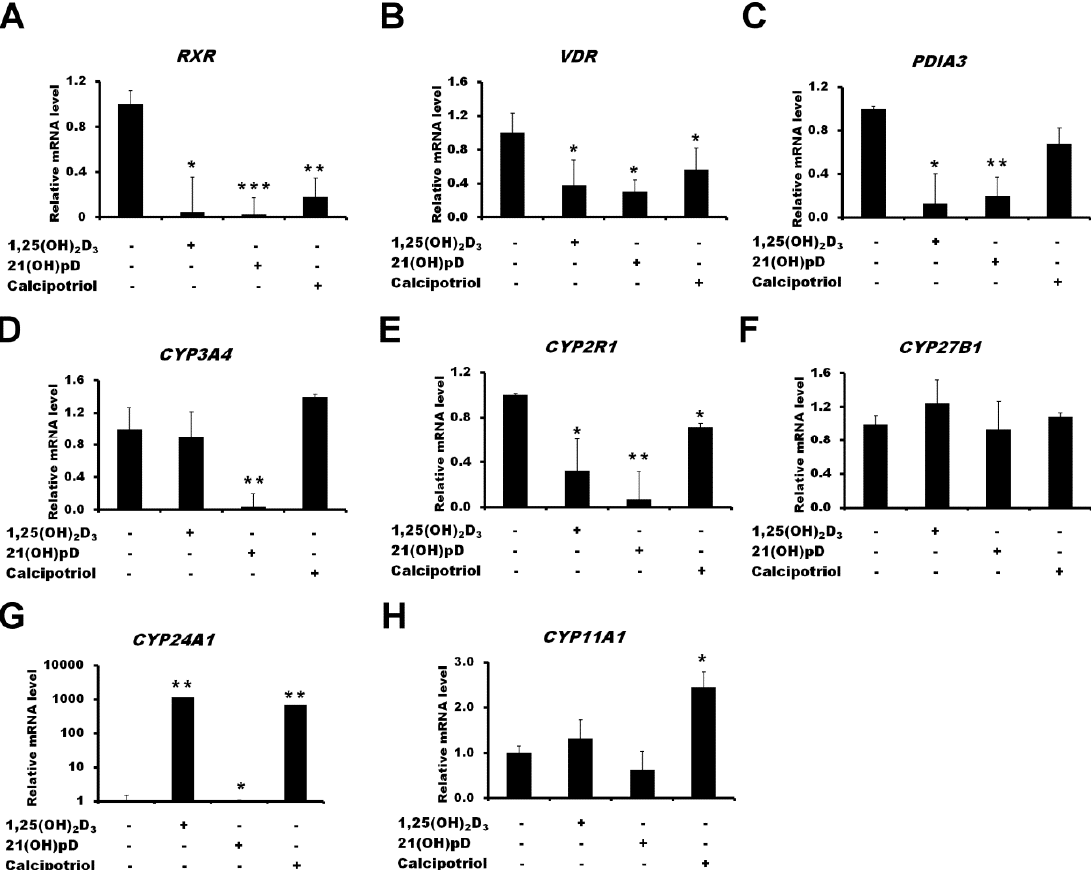
Figure 5. Effects of vitamin D compounds (1,25(OH) 2 D 3 , 21(OH)pD or calcipotriol) on RXR ( A ), VDR ( B ), PDIA3 ( C ), CYP3A4 ( D ), CYP2R1 ( E ), CYP27B1 ( F ), CYP24A1 ( G ) and CYP11A1 ( H ) genes expression in A375 melanoma cells. A375 melanoma cells were incubated with 100 nM of 1,25(OH) 2 D 3 , 21(OH)pD or calcipotriol for 24 h. mRNA levels were measured by qPCR. Data are shown as means ± S.D of three independent experiments carried out in duplicate. The cutoff point for significance is defined as p < 0.05 (* p < 0.05, ** p < 0.01, *** p < 0.001).